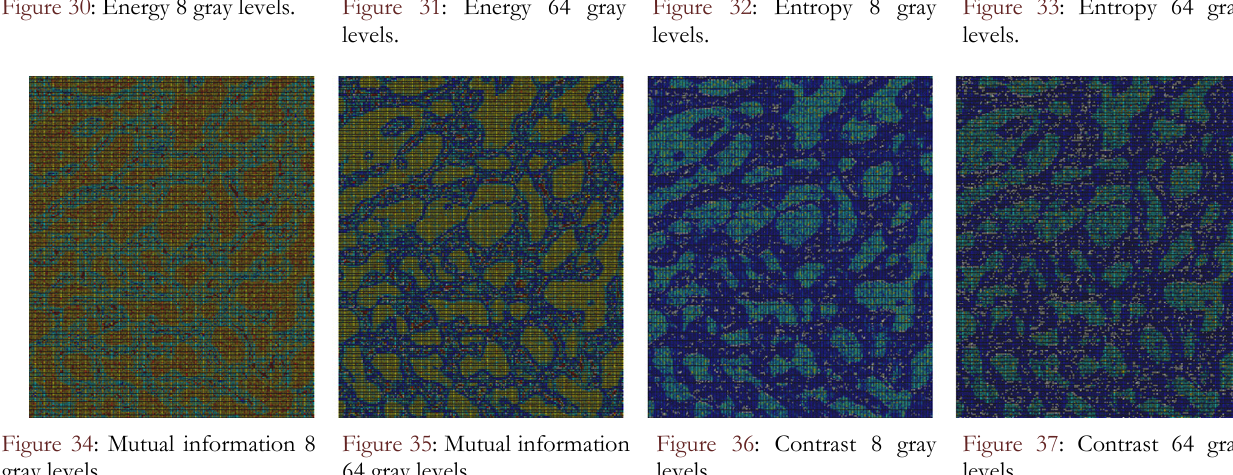
Figure 30: Energy 8 gray levels. Figure 31: Energy 64 gray